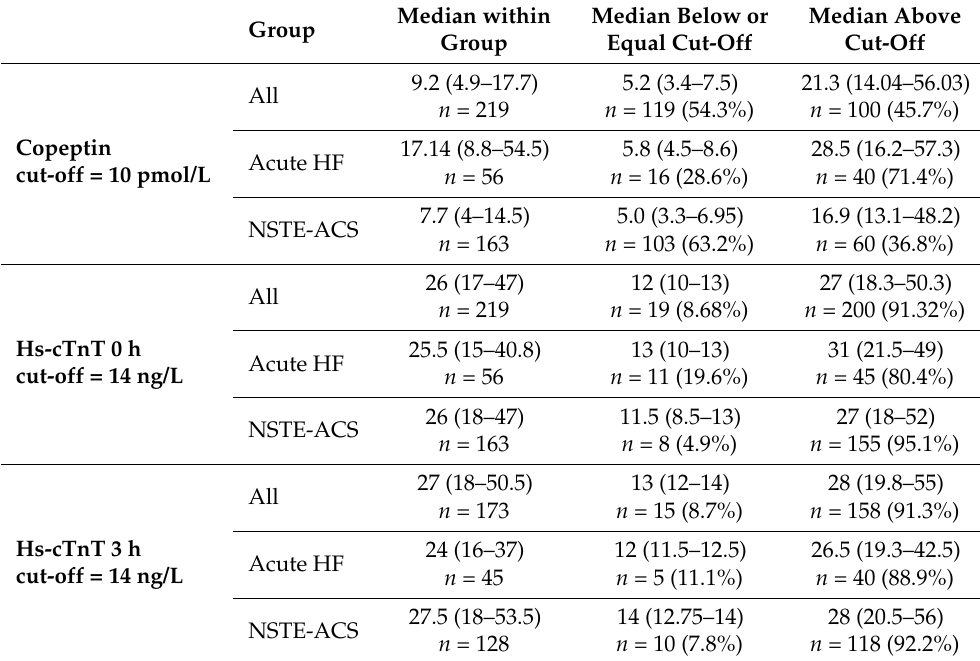
Table 2. Median serum concentration with respect to 99th percentile cut-off